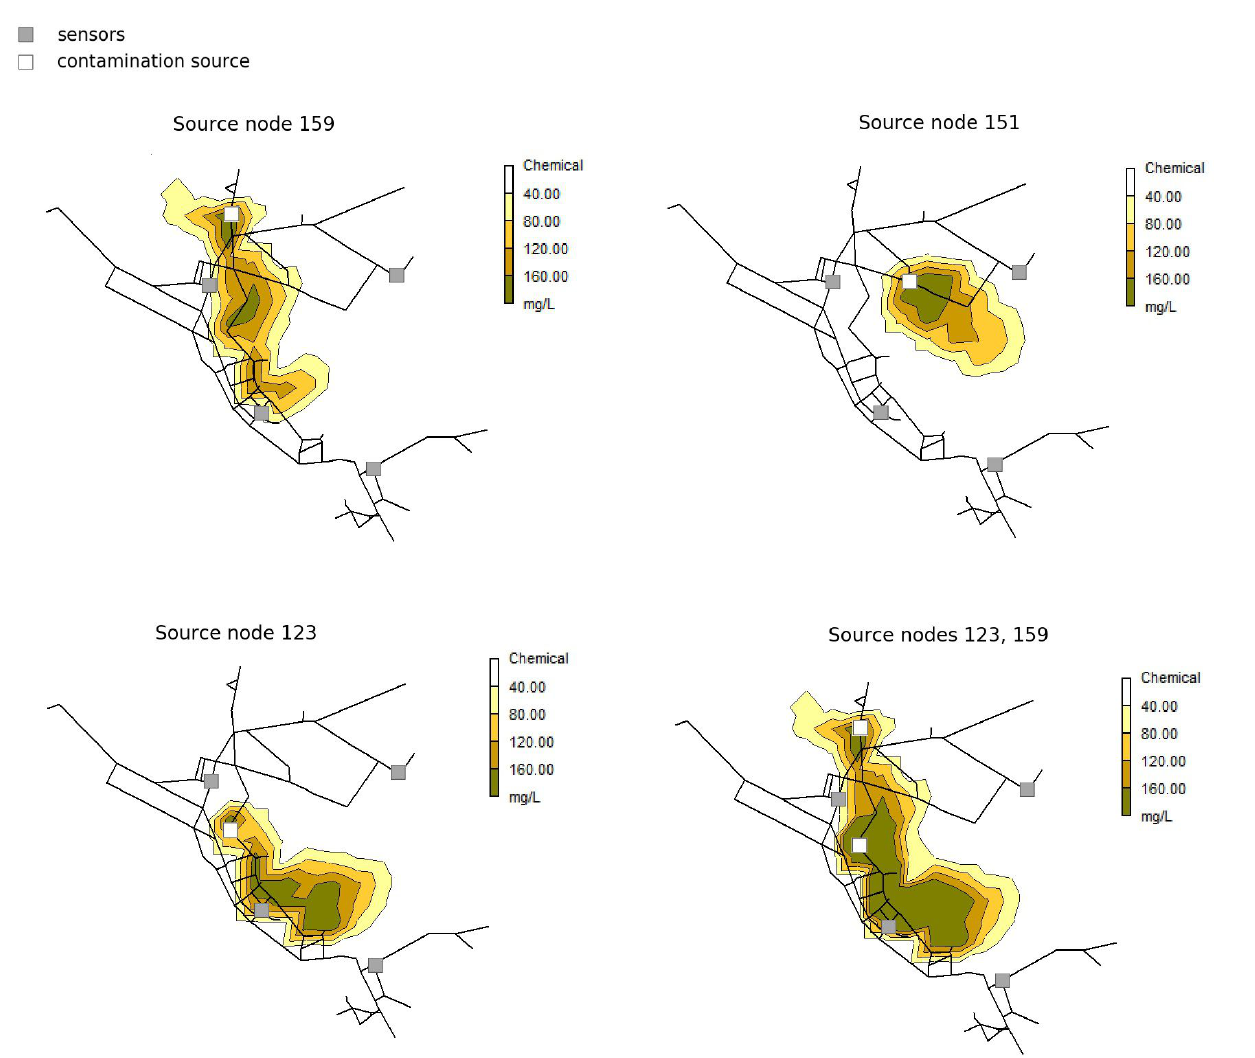
Figure 3. Contours of chemical for randomly chosen Net3 contamination scenario 90 min after injection starting time. Contamination from source node 151 remains undetected, so the source node is not included for multiple injections